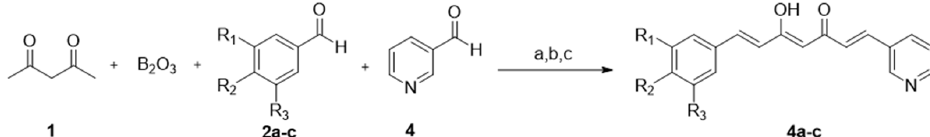
Scheme 1. Synthesis of different pyridine curcuminoids 4a-c. Reagents and conditions: (a) B(n-BuO) 3 ;